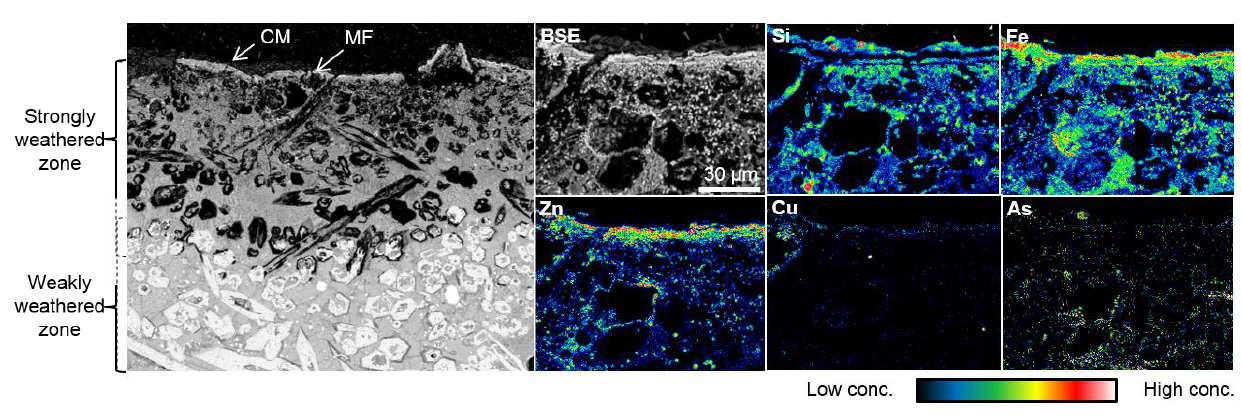
Figure 4. Back-scattered electron images and the elemental maps of weathered slag obtained by SEM-EDS. MF: Metal film-like structure; CM: Clay minerals.